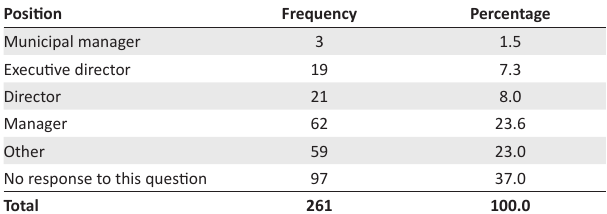
TABLE 4: Frequency table of the positions of the respondents.